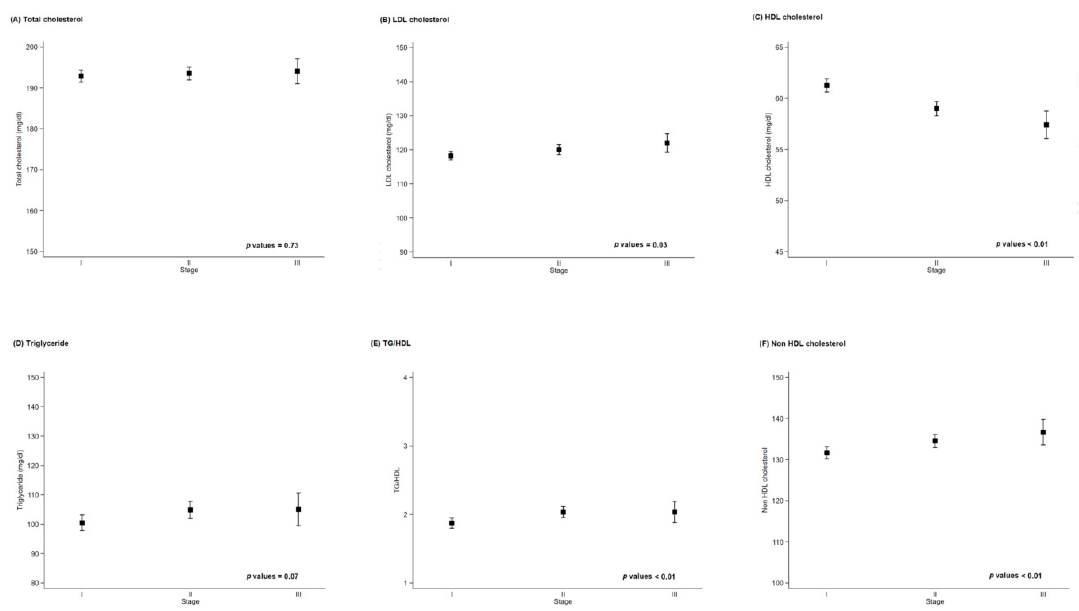
Figure 2. Baseline lipid marker by disease severity. HDL: high density lipoprotein; LDL: low density lipoprotein; TG: lipoprotein; TG: triglycerides.